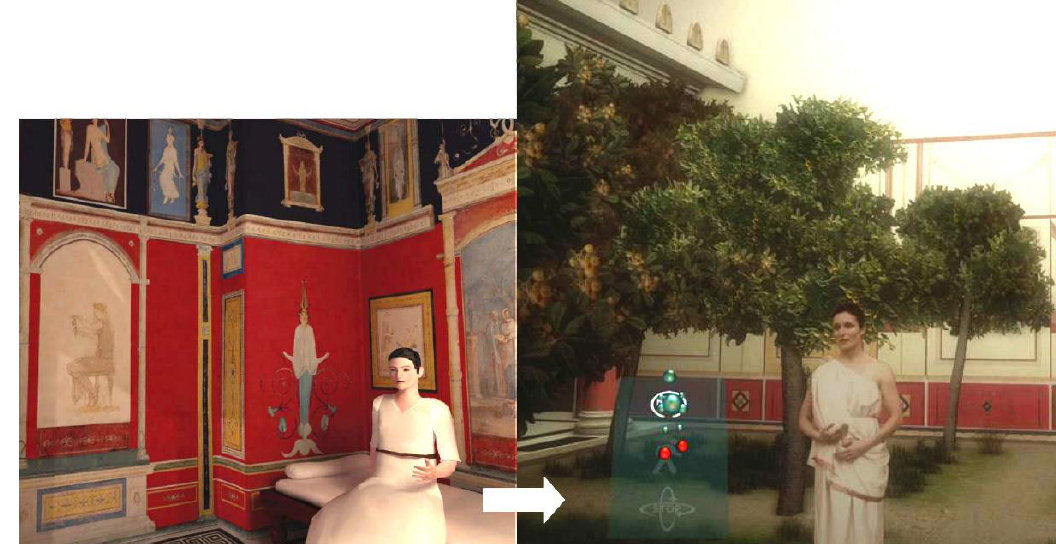
Figure 11. Livia’s Villa VR. reconstructed villa with Empress Livia telling her private stories in the cubiculum and in the private garden. In the first version of 2008 characters were used, in the updated version of 2014 they were replaced by real actors. CNR ITABC, National Roman Museum of Diocletian’s Baths, Rome.